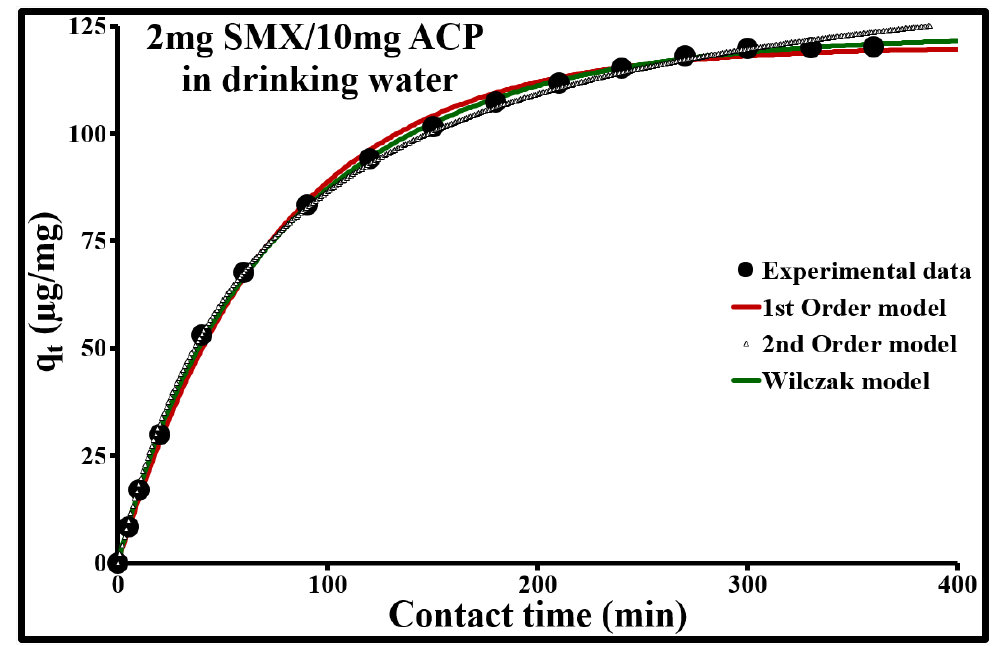
Figure 8. Comparison of adsorption kinetic models at 293 K for 2 mg/L of SMX and 10 mg/L of ACP Norit SA Super in drinking water.